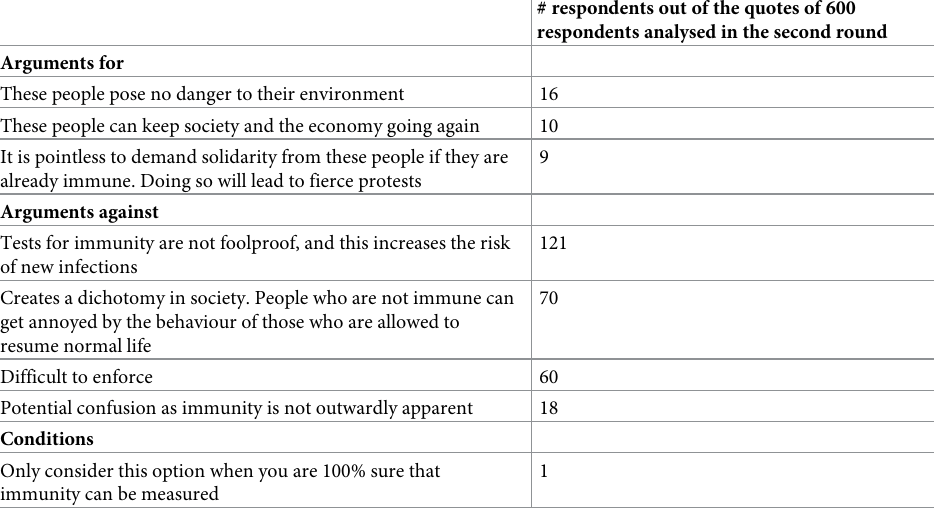
# respondents out of the quotes of 600 respondents analysed in the second round